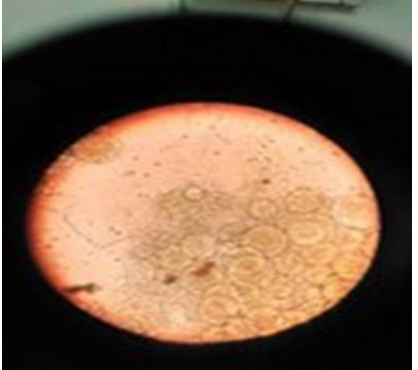
Fig. 1. KOH mount: sporangia filled with spores